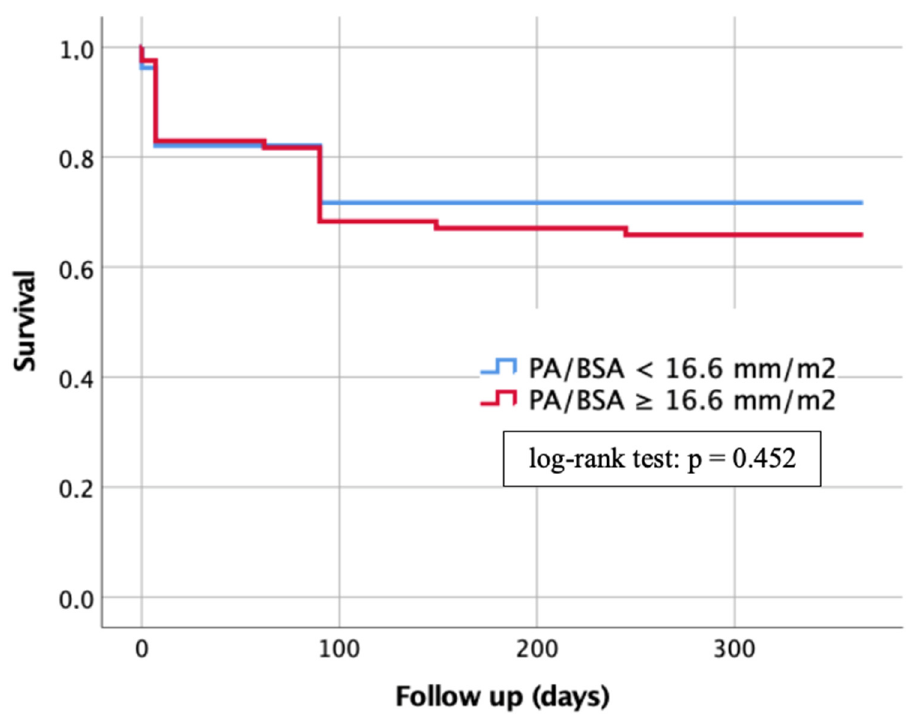
Figure 7. Kaplan–Meier curve for detection of 1-year survival in dependence of a PA/BSA cut-off value ≥ 16.6 mm/m 2 . PA: pulmonary artery; BSA: body surface area.